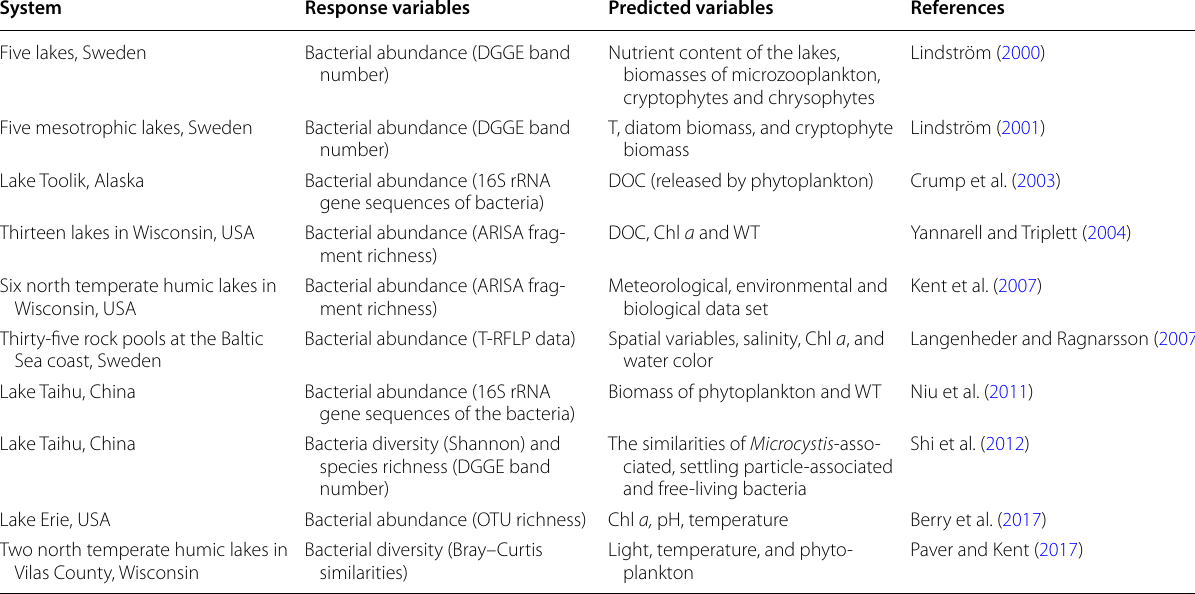
Table 1 Coupled effects of environmental factors and phytoplankton communities on the bacterial communities of the water